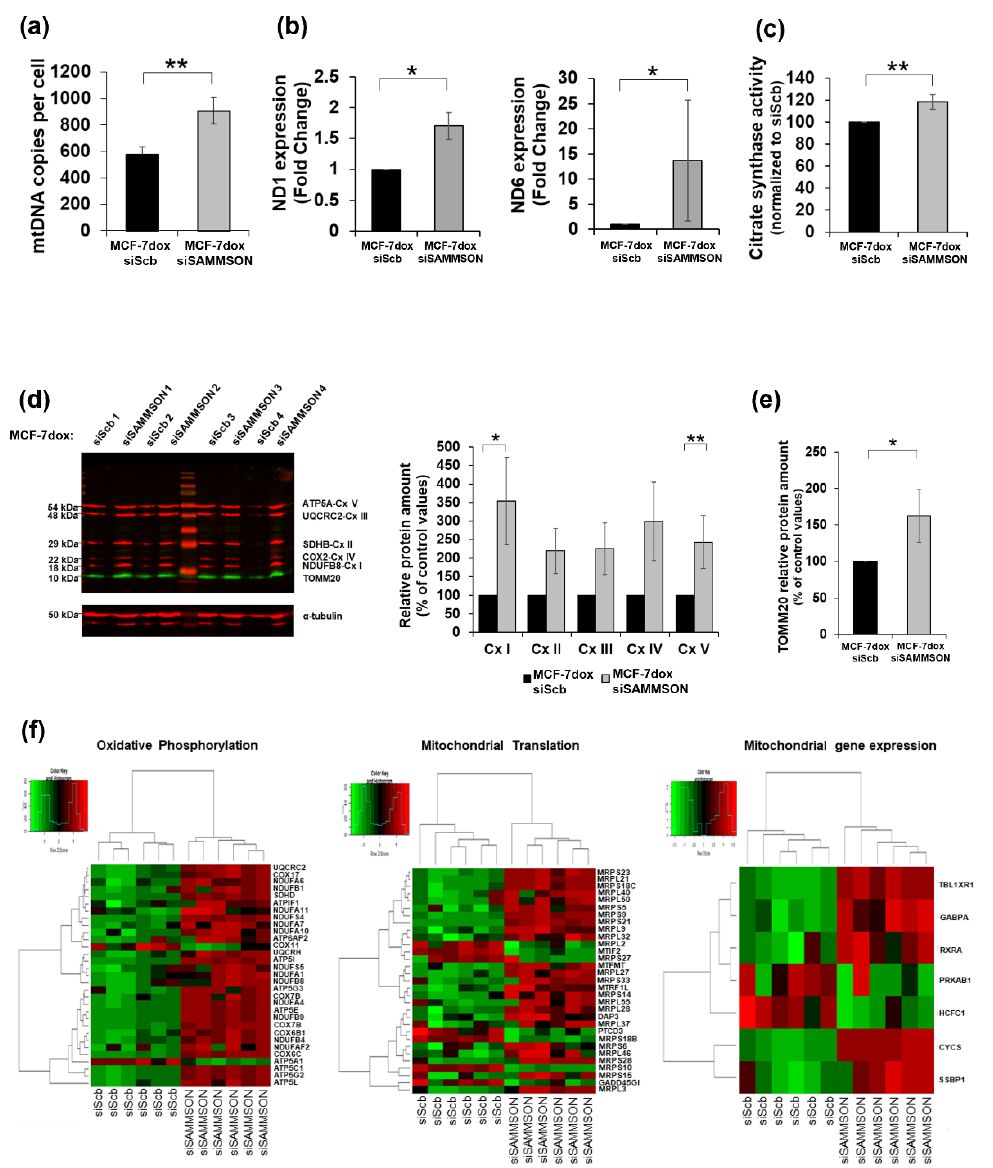
Figure 3. Impact of SAMMSON silencing in mitochondrial replication, transcription and translation in MCF-7dox cells. ( a ) Quantification of the mitochondrial DNA (mtDNA) in the MCF-7dox siScb and siSAMMSON cells. The ratio of the mtDNA/nuclear DNA was analyzed using qPCR. The data are represented by the mean ± SEM mtDNA copies per cell of n = 5 MCF-7dox siScb and siSAMMSON cells. ( b ) Quantification of the mitochondrial RNA ND1 and ND6 in the MCF-7dox siScb and siSAMMSON cells via RT-qPCR. Data are represented by the mean ± SEM of n = 4 MCF-7dox siScb and siSAMMSON cells. ( c ) Citrate synthase activity was measured in duplicate on crude cell lysates and normalized to the total amount of proteins. The data are represented by the mean ± SEM of n = 8 MCF-7dox siScb and siSAMMSON cells. ( d ) Western blot of OXPHOS mitochondrial complexes performed on MCF-7dox siScb and siSAMMSON cell lysates. An antibody cocktail was used to examine the expression of five mitochondrial proteins. Left panel: representative blot; right panel: quantification of respiratory chain complexes (Cx I, Cx II, Cx III, Cx IV and Cx V) normalized to α -tubulin protein quantity. Data are represented by the mean ± SEM of n = 6 for MCF-7dox siScb and siSAMMSON cells. ( e ) Quantification of the mitochondrial marker TOMM20 normalized to α -tubulin. ( f ) Heatmap of differentially expressed genes in mitochondrial pathways in MCF-7dox siScb and siSAMMSON treated cells. For panels ( a – e ), p -values were calculated using the Mann– Whitney test, with * p < 0.05 and ** p <